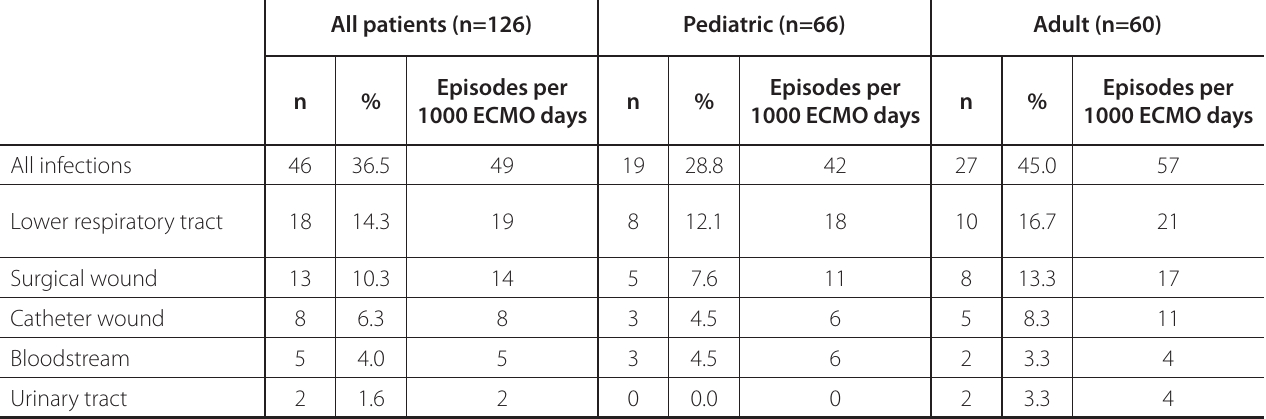
Table 3 . Distribution of nosocomial ECMO infections by site of